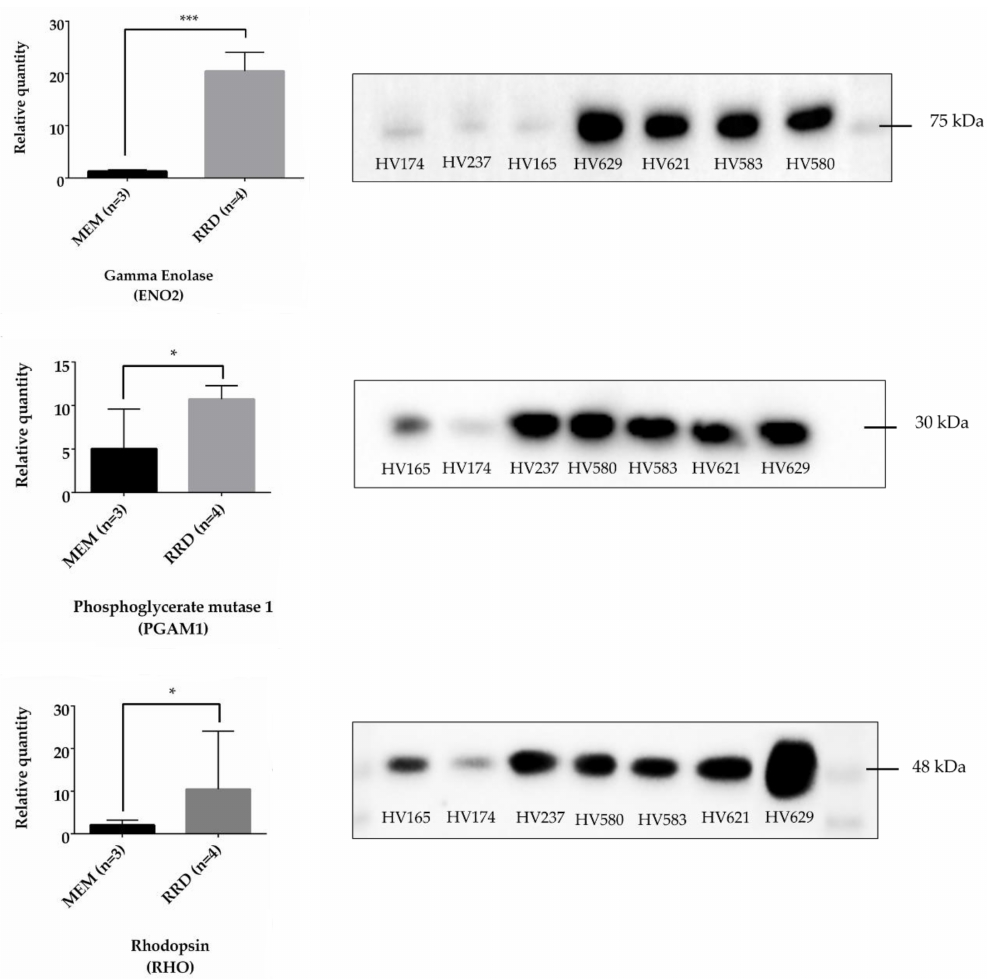
Figure 3. Western blot analyses of ENO2, PGAM1, and RHO in vitreous samples from patients with MEM (HV165, 174 and 237) and RRD (HV580, 583, 621 and 629). Statistics analysis were performed using Mann–Whitney U test, with * and *** representing p < 0.05 and p = 0.0007,